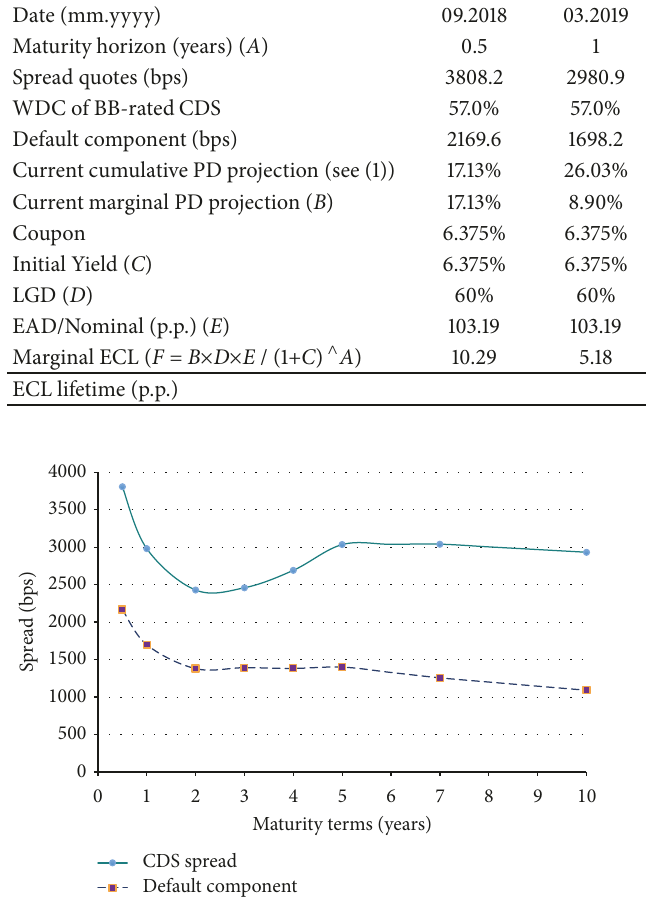
Figure8:WindstreamServicestermstructures:CDSspreadandthe default component.